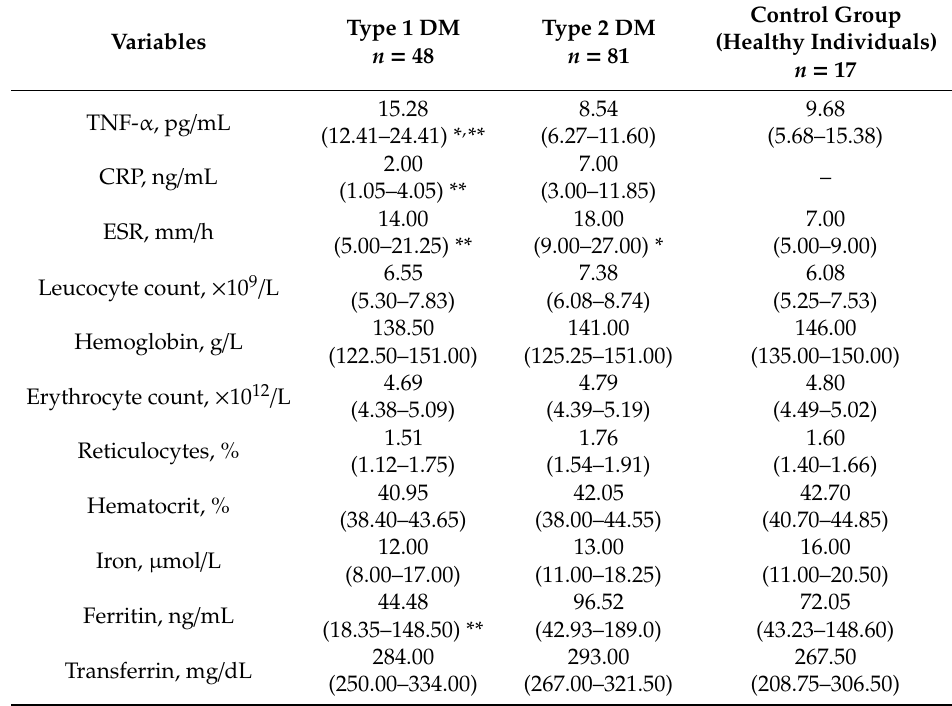
Table 2. Inflammatory markers and iron metabolism indices in patients with diabetes mellitus (DM) and in the control